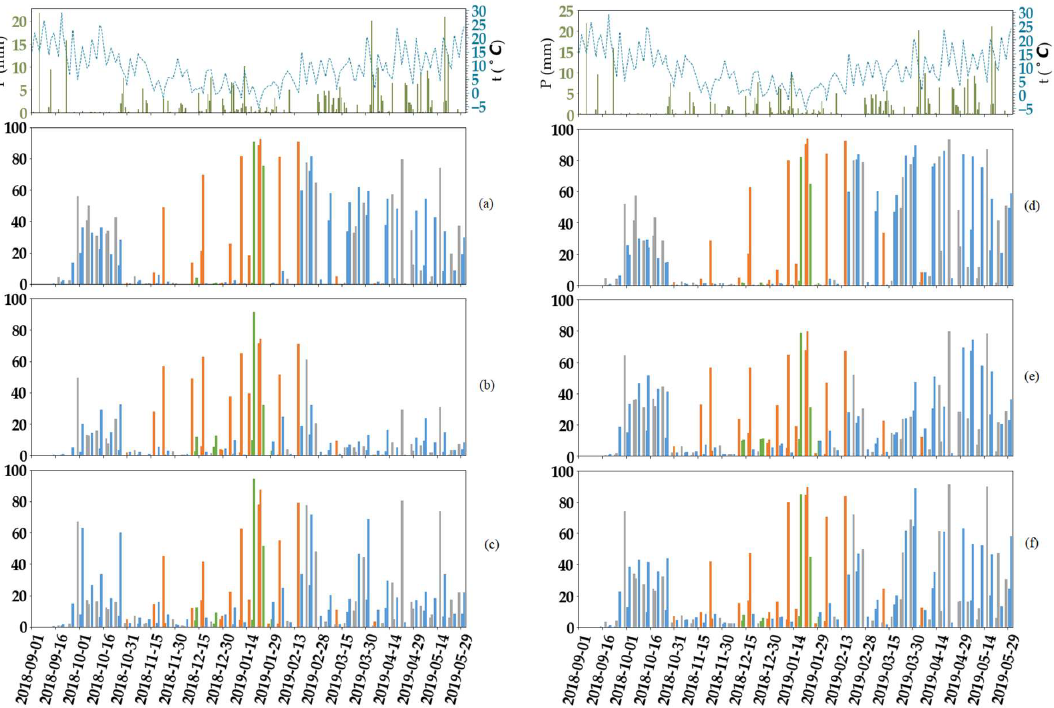
Figure 10. Percentage of plots detected as frozen in site B for each S1 acquisition date, using VH and VV polarizations. ( a ) VH-LC1, ( b ) VH-LC2, ( c ) VH-LC3, ( d ) VV-LC1, ( e ) VV-LC2, ( f ) VV-LC3. Precipitation (P) and temperature (t) are given in the graph at the top.